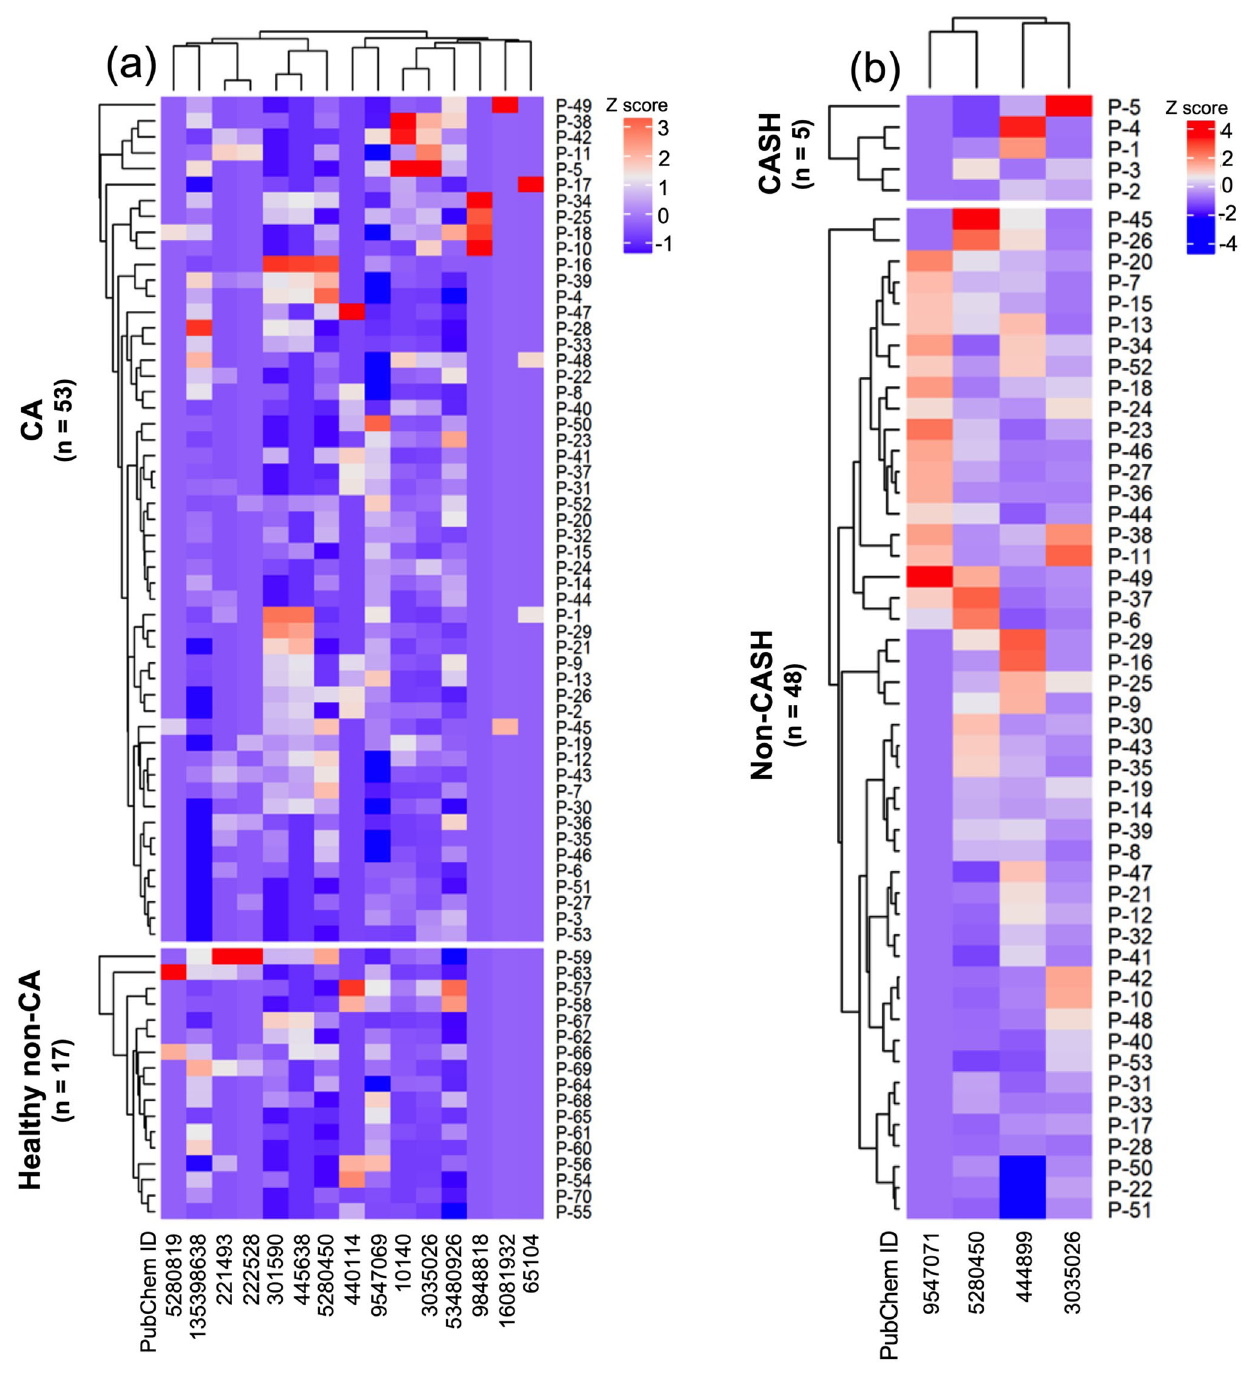
Fig. 2 Heatmaps of the differential metabolomic pro fi les in cavernous angioma (CA) disease and its clinical manifestations. A PLS-Discriminant Analysis showed differences in the plasma levels for ( a ) 15 metabolites between CA patients ( n = 53 biologically independent patient samples) and healthy non-CA subjects ( n = 17 biologically independent patient samples), ( b ) four metabolites between cavernous angioma with symptomatic hemorrhage (CASH) patients ( n = 5 biologically independent patient samples) and cavernous angioma without symptomatic hemorrhage (non-CASH) patients ( n = 48 biologically independent patient samples) ( p < 0.05, FDR corrected; Bayes factor>3). Z-scores were calculated to compare metabolite levels across patients within each comparison group, with lower z scores (darker blue) representing lower relative plasma levels of metabolites. Metabolites with listed PubChem IDs are identi fi ed in Supplementary Tables 2, The four differentially present plasma metabolites identi fi ed in ( n = 20) patients identi fi ed among subsequent prospectively CASH patients, compared to non-CASH, were validated in an enrolled subjects, was used to validate the metabolomic fi ndings independent propensity matched cohort . A CASH is a cardinal (Supplementary Table 4). Twenty CASH and 20 non-CASH patients were propensity score matched. The supervised PLS-DA event in the clinical course of CA disease 14 . An independent propensity matched cohort of CASH ( n = 20) and non-CASH also showed that plasma ratio levels of linoleic (Supplementary